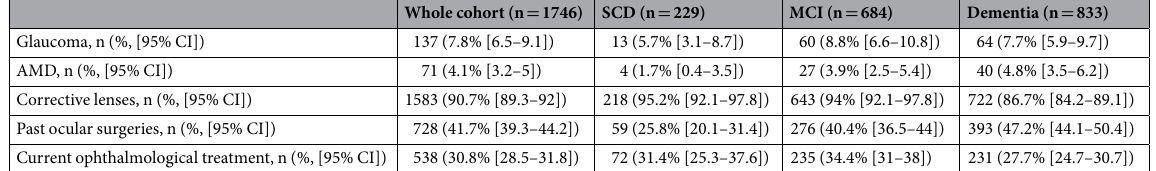
Table 2. Past ophthalmological history of the study cohort. AMD = age-related macular degeneration; CI = confidence interval; MCI = mild cognitive impairment; SCD = subjective cognitive